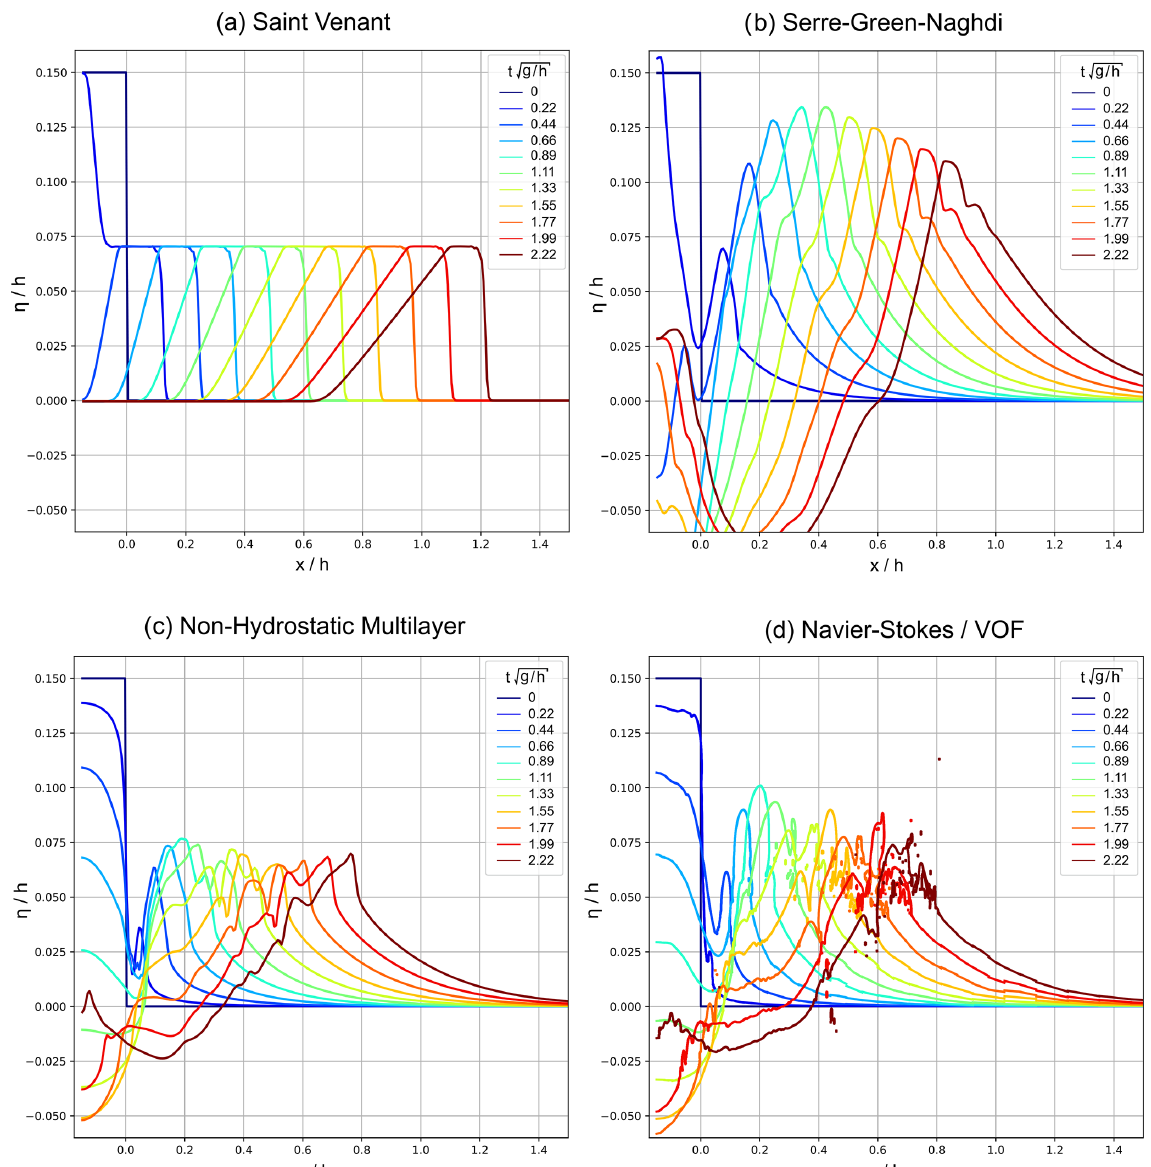
Figure 4. Comparison of numerical solutions for the disturbance collapse from initialisation to t = 0 . 5s. Distances are normalised with water depth h and are vertically